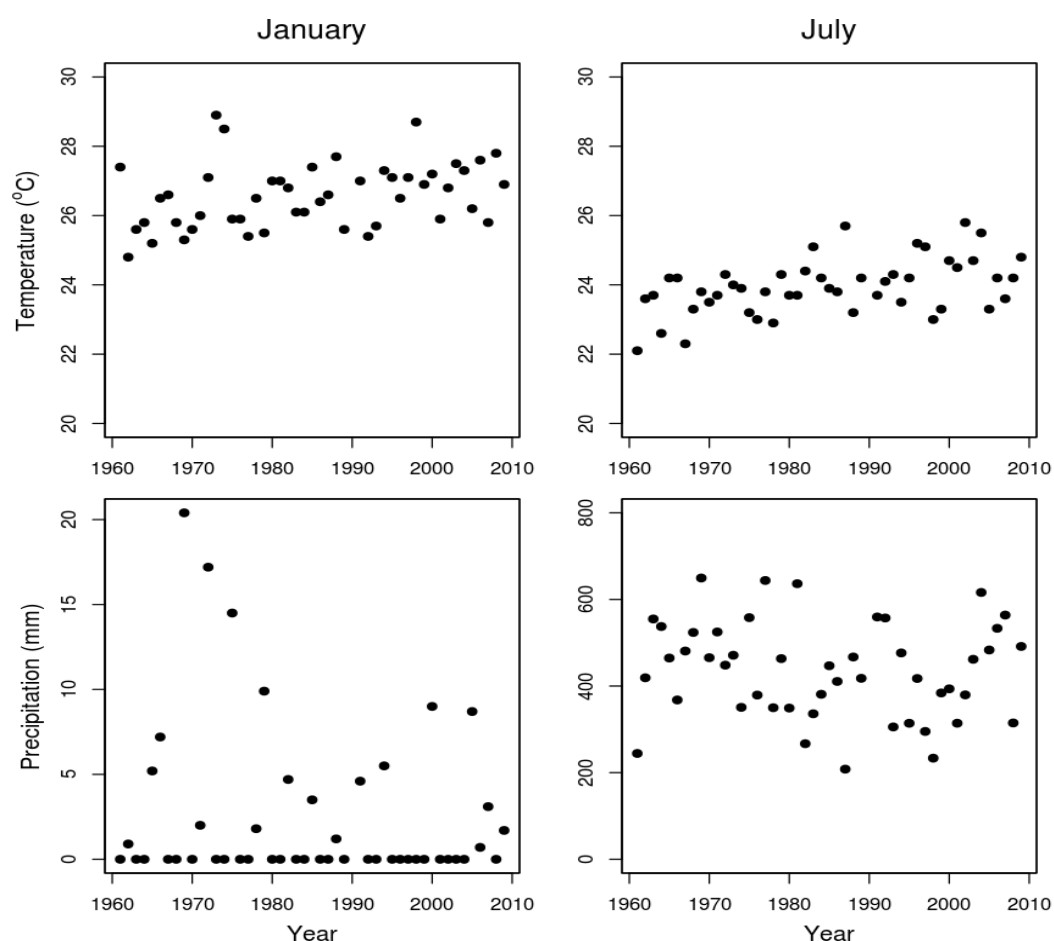
Figure 1. Mean maximum temperature (in °C) and rainfall (in mm/month) for .the years 1961–2009 at .Bahirdar